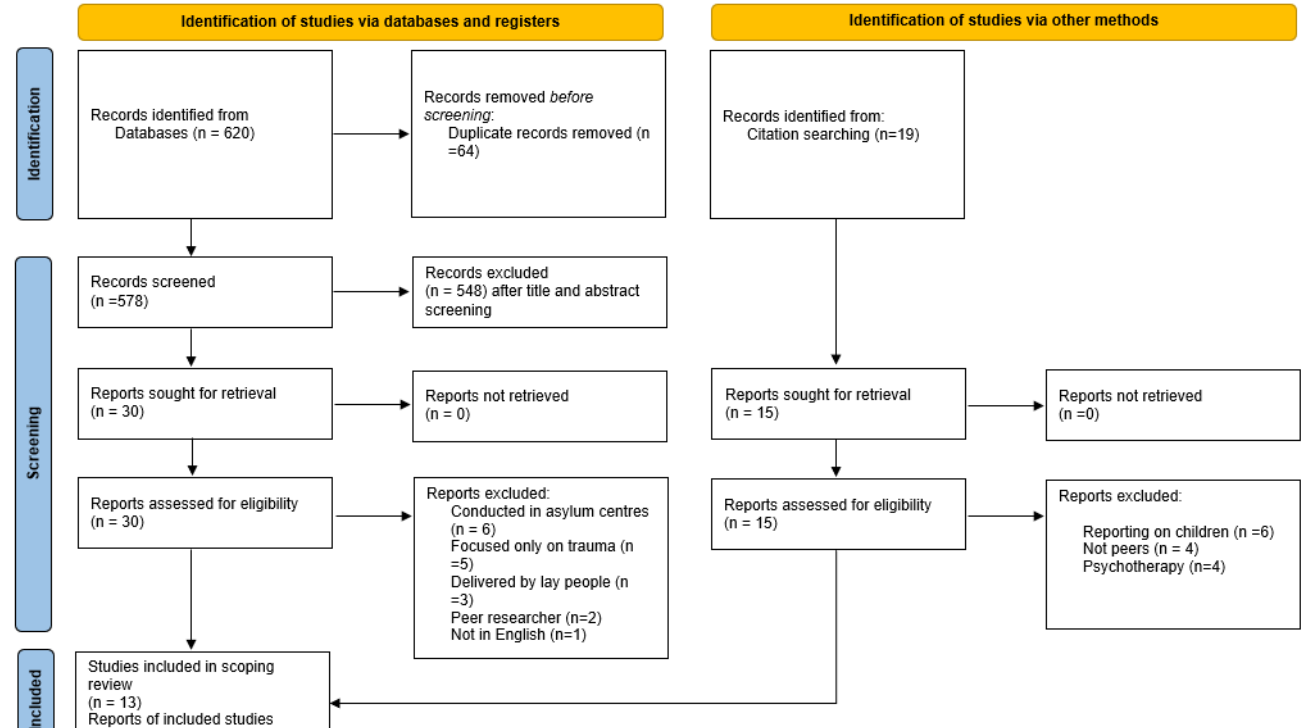
Figure 1. PRISMA Flowchart adaptation as outlined by Page et al [38].